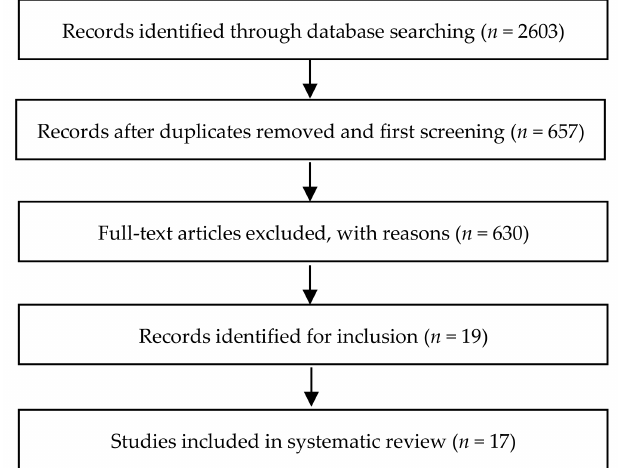
Figure 1. Preferred Reporting Item for Systematic Reviews and Meta-Analysis (PRISMA) flow of information.